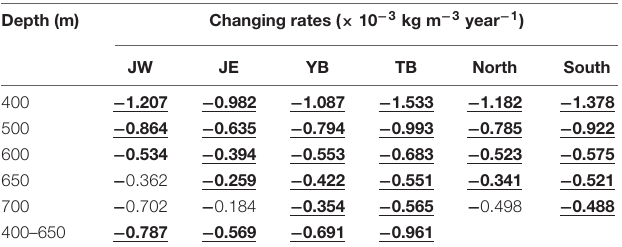
TABLE 2 | Changing PD rates in JW, JE, YB, and TB based on the Argo data. Bold and bold-underlined figures indicate statistically significant data at 95 and 99% confidence levels,